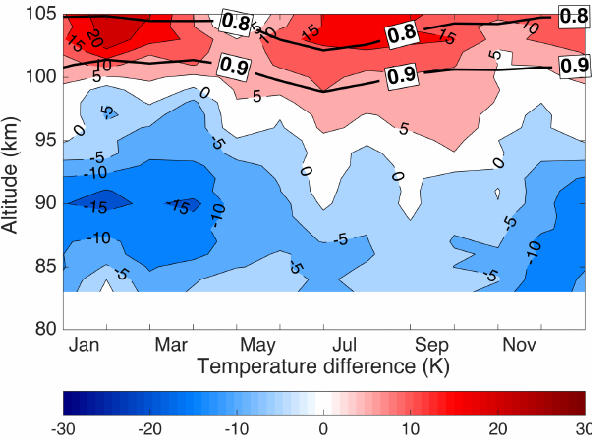
Figure 14. PCL temperature climatology difference from the up- graded CSU (2002–2006) sodium lidar climatology (PCL minus up- graded CSU). The horizontal black lines are the height below which the temperature climatology is more than 90% (0.9) and 80% (0.8) due to the